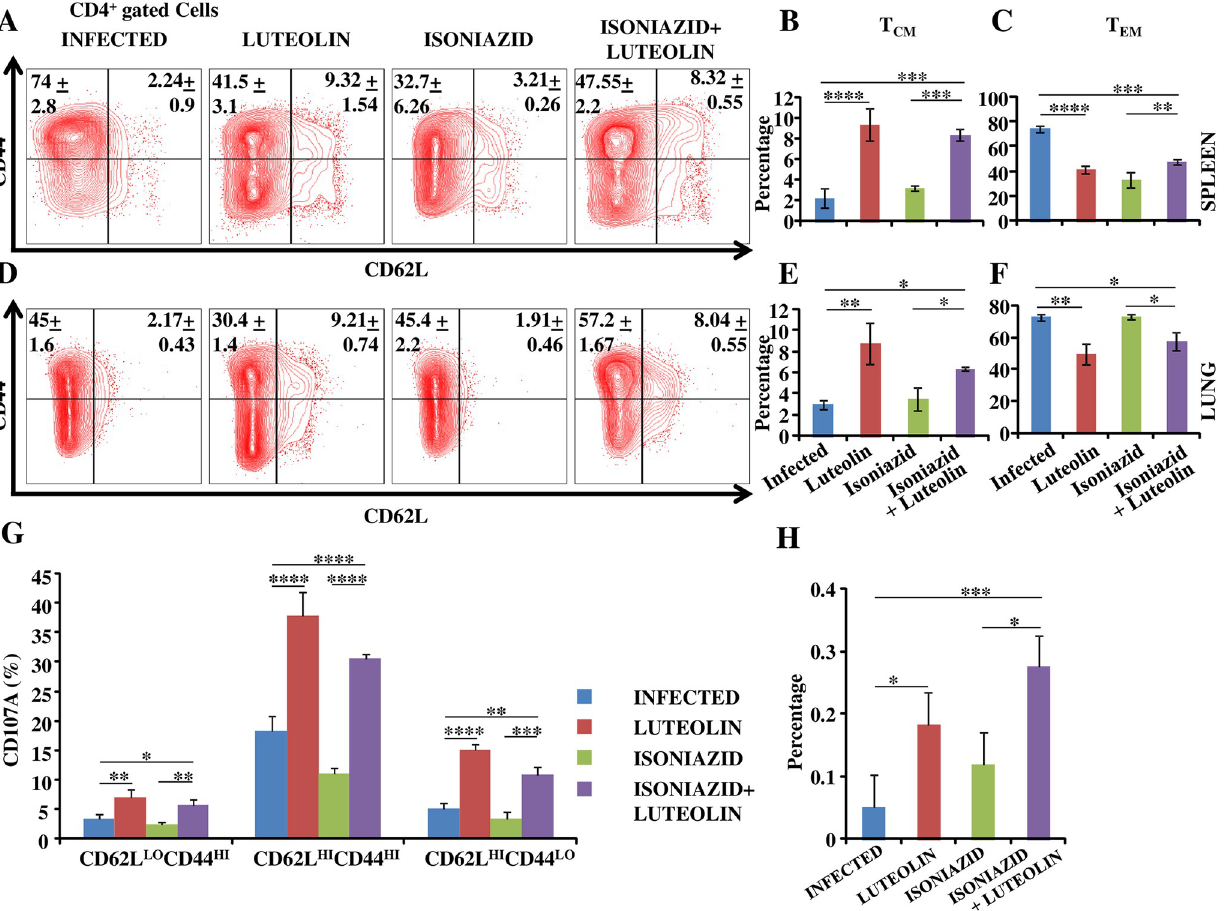
Fig 3. Luteolin induces superior antigen-specific memory T cell responses. T lymphocytes isolated from lungs and spleens of the indicated groups of experimental mice at 60 days post-infection were surface-stained with anti-CD3, -CD4, -CD44, -CCR7 and -CD62L antibodies on ice and fixed prior to acquisition by flow cytometry. Representative FACS profile (A) and proportion of central memory (B) and effector memory (C) subsets of CD4 + T cells in spleen. Representative FACS profile (D) and proportion of central memory (E) and effector memory (F) subsets of CD4 + T cells in lung. (G) Ex-vivo M . tb CSA antigen-specific degranulation in different CD4 + T cell subsets in lung. (H) Multifunctional CD4 + T cell populations in lung of infected, Luteolin- treated, Isoniazid-treated and Luteolin+Isoniazid-treated mice. Data shown here are representative of three independent experiments with three mice in each group and represent the MEAN ± STDEV values. Differences were considered significant at P < 0.05 and are represented by � p < 0.05, �� p < 0.01, ��� p < 0.001, ���� p < 0.0001 whereas non-significant differences are denoted by (NS).